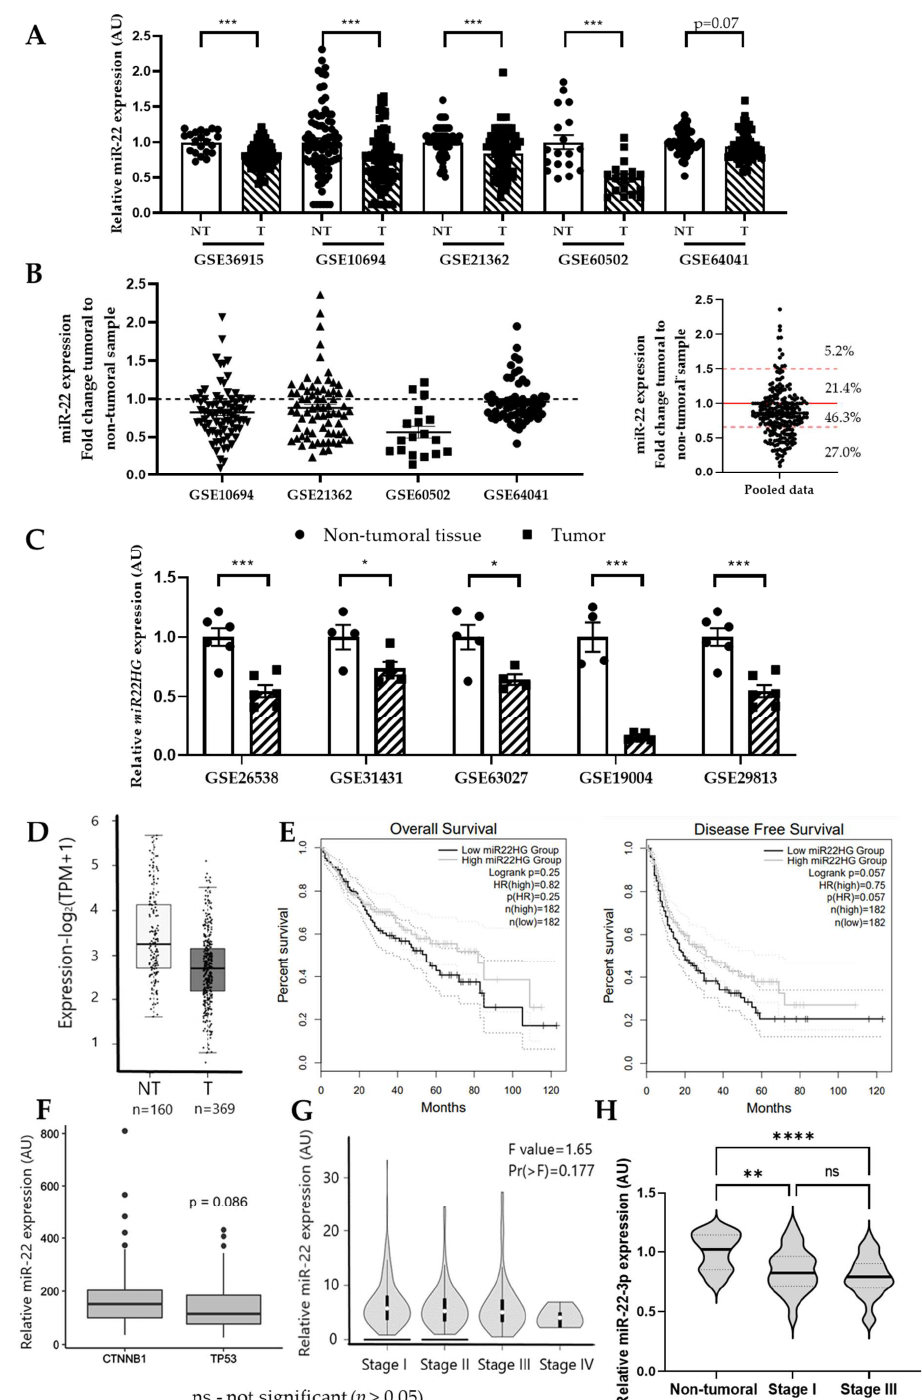
Figure 1. In silico analysis of miR-22 expression in human and rodent hepatocellular carcinoma. ( A ) Analysis of the expression of miR-22-3p or miR22HG in Gene Expression Omnibus (GEO)